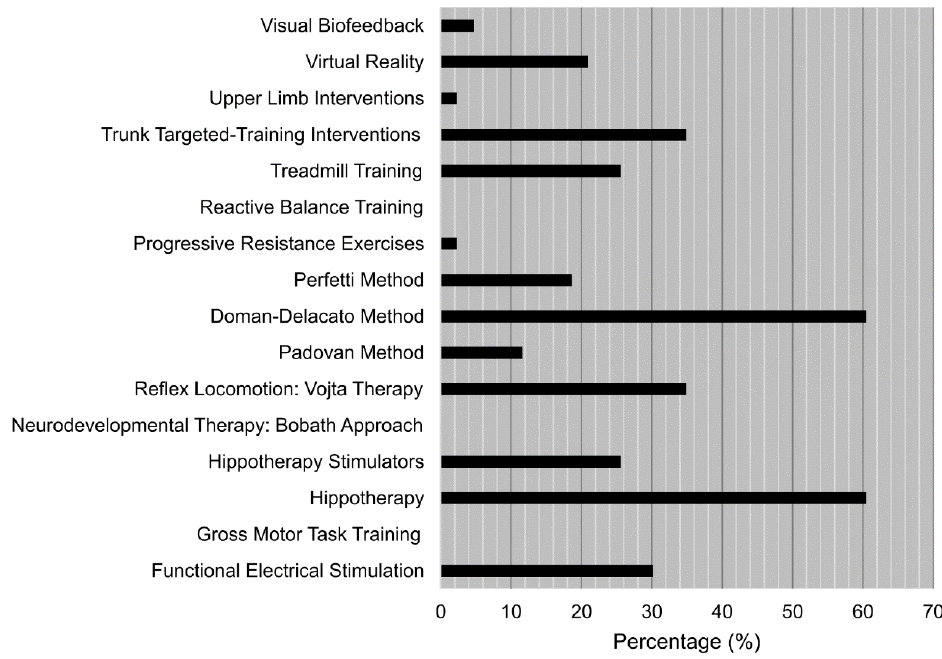
Figure 3. Lower limit (%) of participants who knew each one of the listed treatments but never used them.